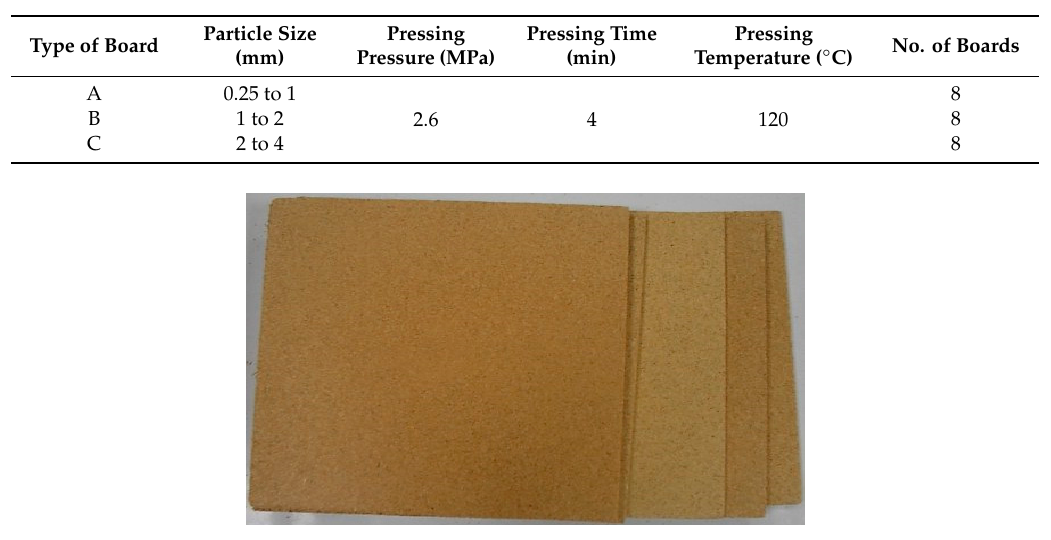
Table 2. Types of board manufactured.